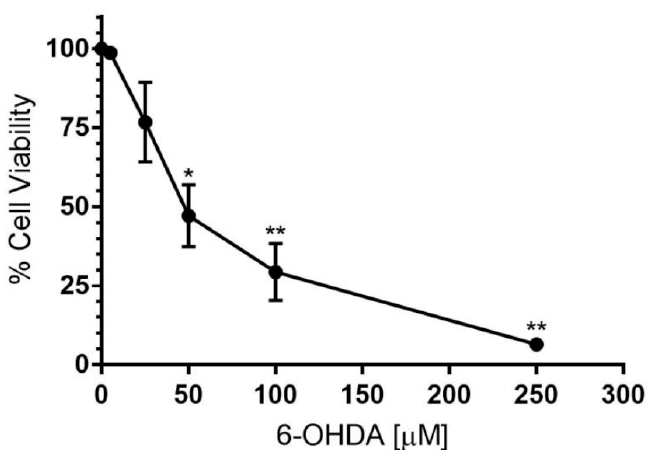
Figure 2. 6-OHDA dose response relationship to SH-SY5Y dopaminergic cell viability. Differentiated SH-SY5Y cells were treated with increasing concentrations (0–250 µ M) of the cytotoxin 6-OHDA for 24 h. Cell viability was assessed with a trypan blue exclusion assay. This viability data indicates that 6-OHDA exhibits an EC 50 of ~50 μ M in the presence of dopaminergic neuronal-like cells cultured under the reported conditions. Data represents mean ± SEM, n = 3 independent experiments. Different to the vehicle-treated control; * p ≤ 0.001, ** p ≤ 0.0001.